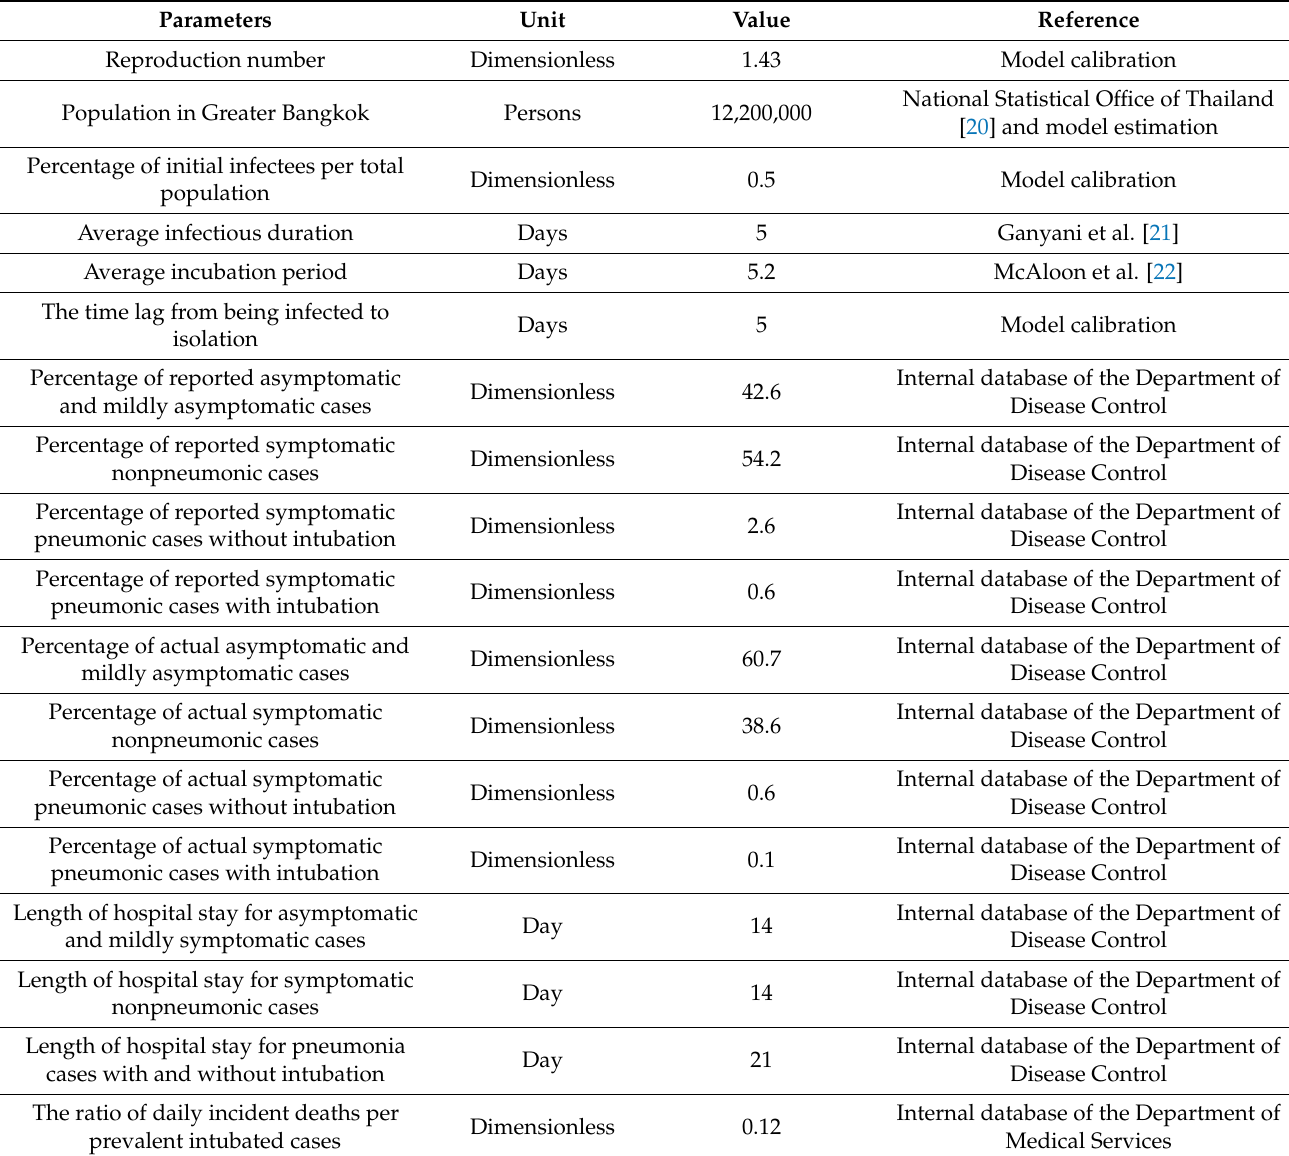
Table 2. List of key parameters.